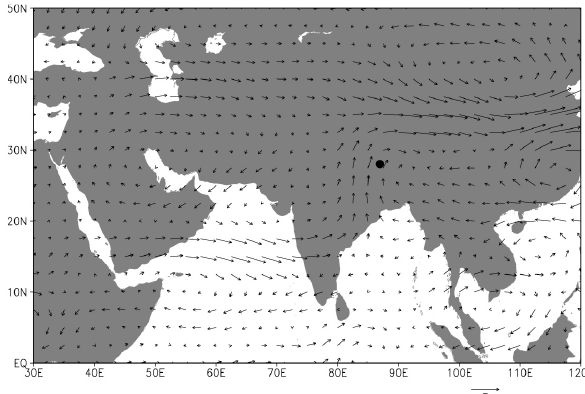
moisture flux (multiplying by wind vector and specific humidity) at 400hPa level between years with higher and lower ER accumula- tion (higher minus lower). The filled black circle indicates the ER core drilling